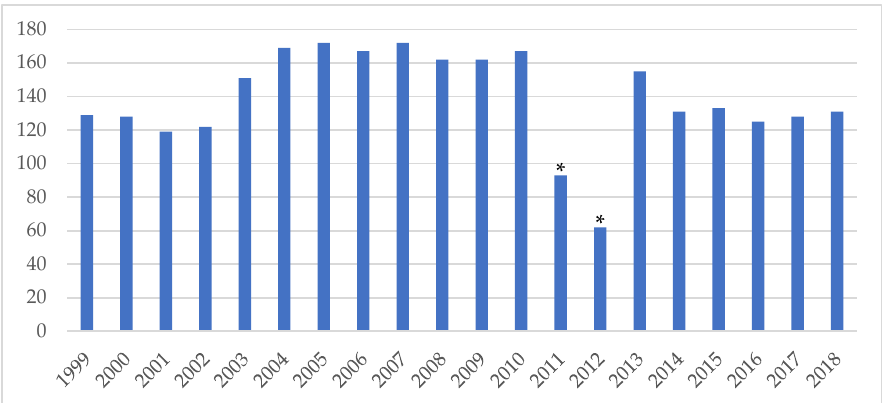
Figure 3. Annual total training capacity for family medicine from 1999 to 2018. *2011 and 2012 were years of a transition of changes in PGY training years. Training capacity was adjusted according to the number of eligible PGY in that